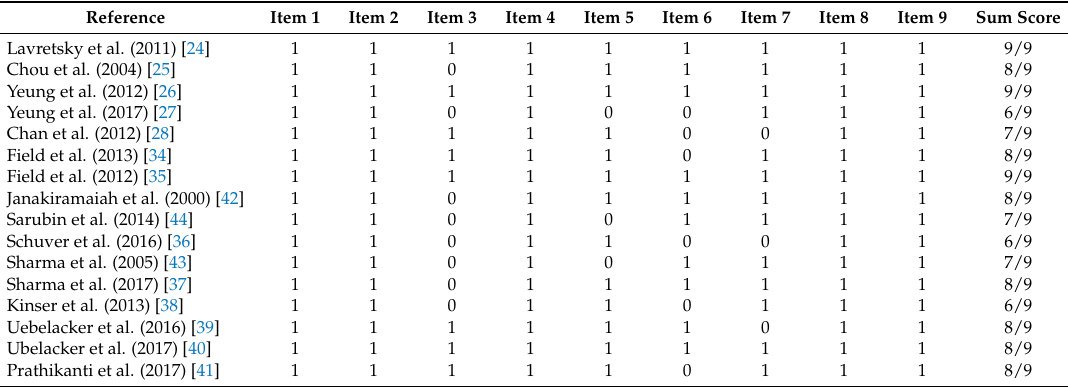
Table 2. Study quality assessment of all selected trials.